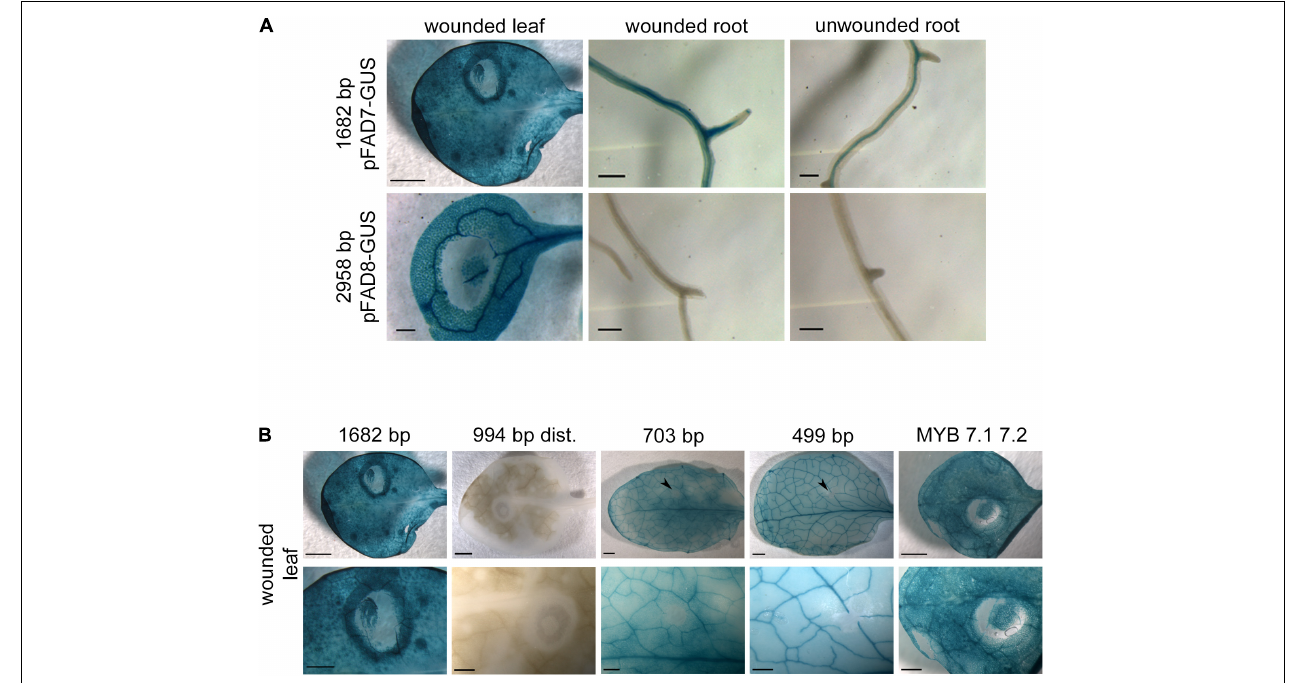
FIGURE 4 | Effect of wounding on the activity of AtFAD7 and AtFAD8 gene promoters. (A) Histochemical GUS staining in wounded leaf, wounded root and unwounded root in transgenic lines carrying the 1,682 bp AtFAD7 gene promoter fragment (upper panels) and the 2,958 bp AtFAD8 gene promoter fragment (lower panels). Histochemical GUS assay was performed in 2-week old rosette leaves. GUS staining was performed for 1 or 3 h for AtFAD7 and AtFAD8 gene promoters, respectively. Images are representative of at least three independent transgenic lines. Scale bars represent 500 µ m in leaves and 200 µ m in roots. (B) Histochemical GUS localization of AtFAD7 promoter activity after 1 h of wounding treatment and 1 h of GUS staining in the 1,682 bp control fragment, the 994 distal promoter deletion, the 703 bp and the 499 bp deletions and in transgenic lines carrying the 1,682 bp sequence in which the two MYB target sequences were modified by site-directed mutagenesis. The upper panel shows the complete leaf and the lower panel a detail of the leaf zone in which the wounded treatment was performed. MYB 7.1 7.2 represents the lines carrying the site-directed mutation on the MYB target sequences. Histochemical GUS assay was performed in 2-week old rosette leaves. Images are representative of at least three independent transgenic lines. Scale bars represent 1,000 µ m for the upper panel (entire leaf) and 500 µ m for the lower panel